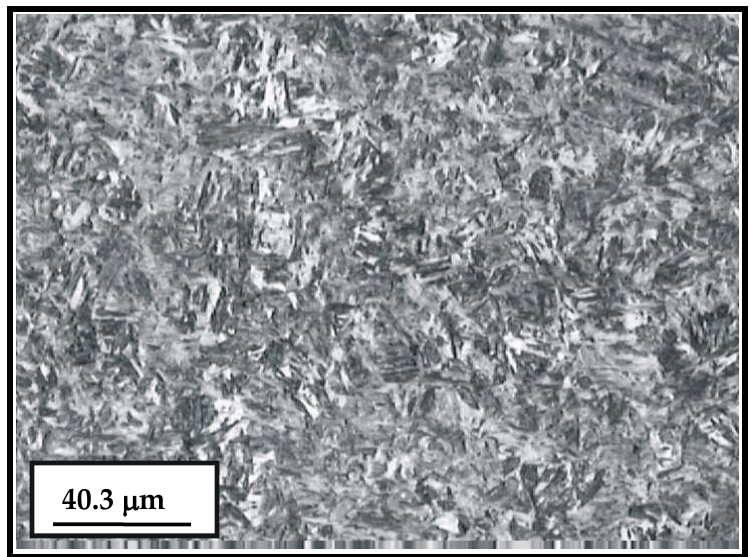
Figure 6. Structure of the cemented sample bulk.